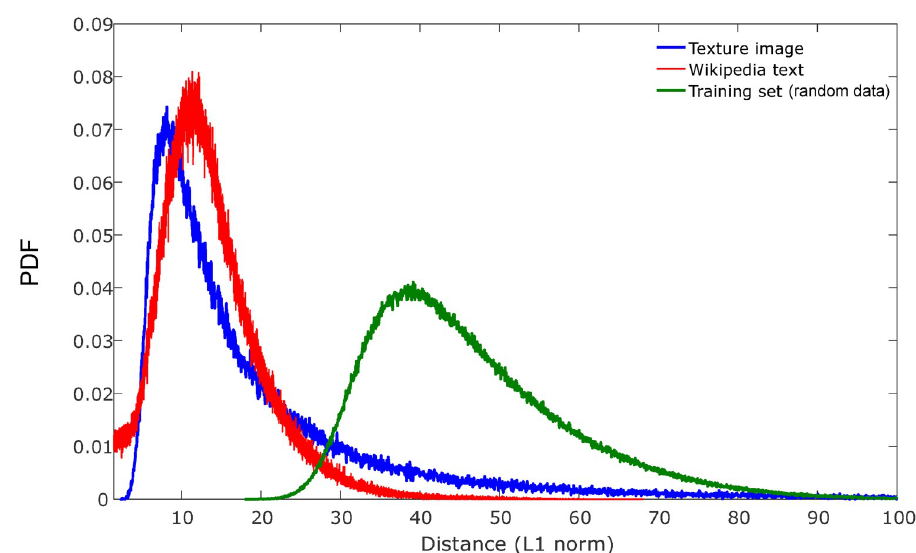
Fig 5. Aggregate distance (L1 norm) distributions of training, texture image and Wiki text data. The probability density functions (PDF) of partitioning distances with respect to each dataset differ significantly. The distribution for random training data is broader and more symmetric, whereas the text and image data have distributions that are more peaked and skewed, with the image data having a longer right-sided tail in its distribution, whereas the Wiki text distribution has a “shoulder” at small distances that does not go to zero, indicating clusters with significant